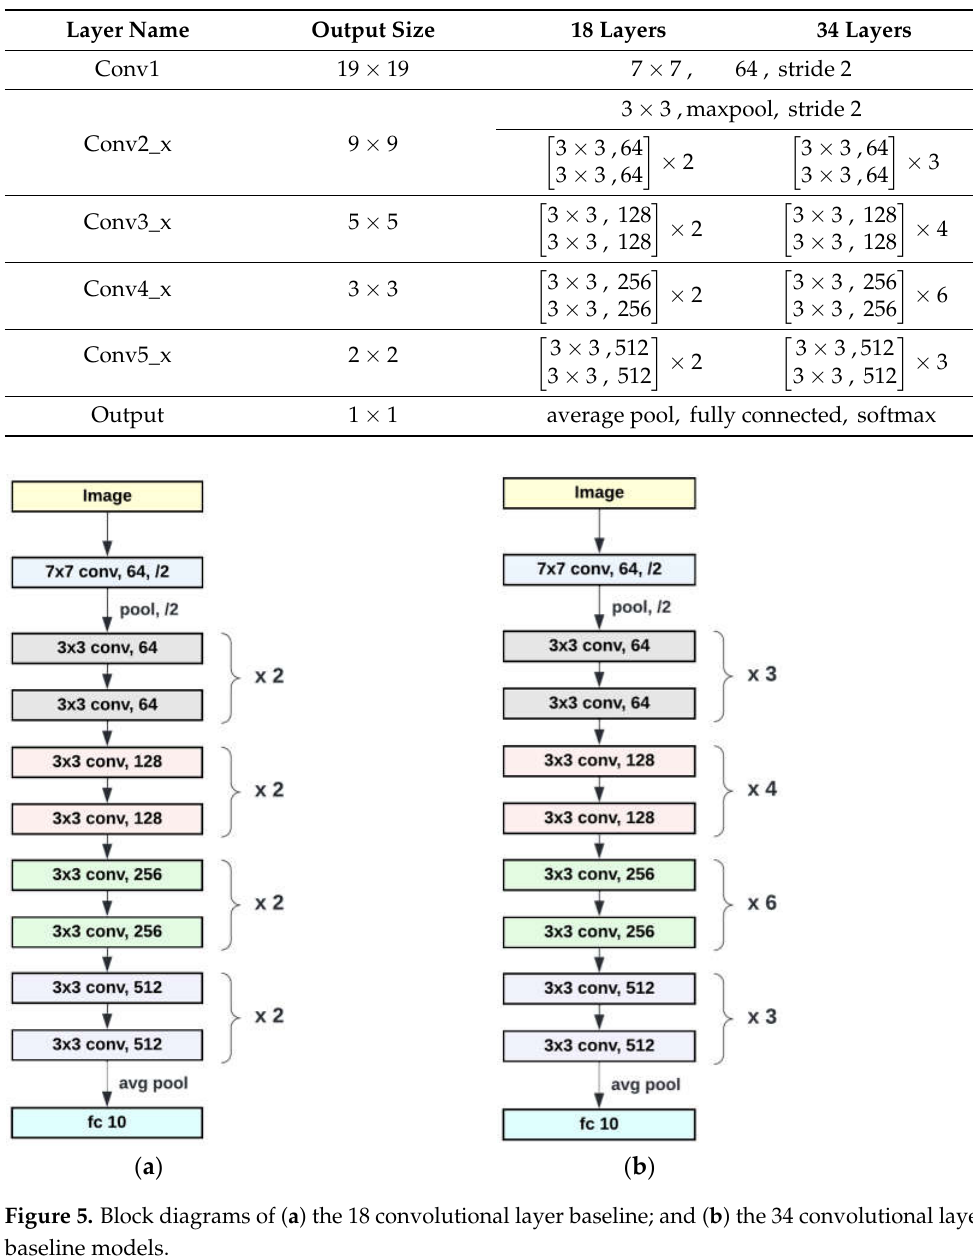
Table 2. Detailed architecture of 18 convolutional layer baseline and 34 convolutional layer baseline models.